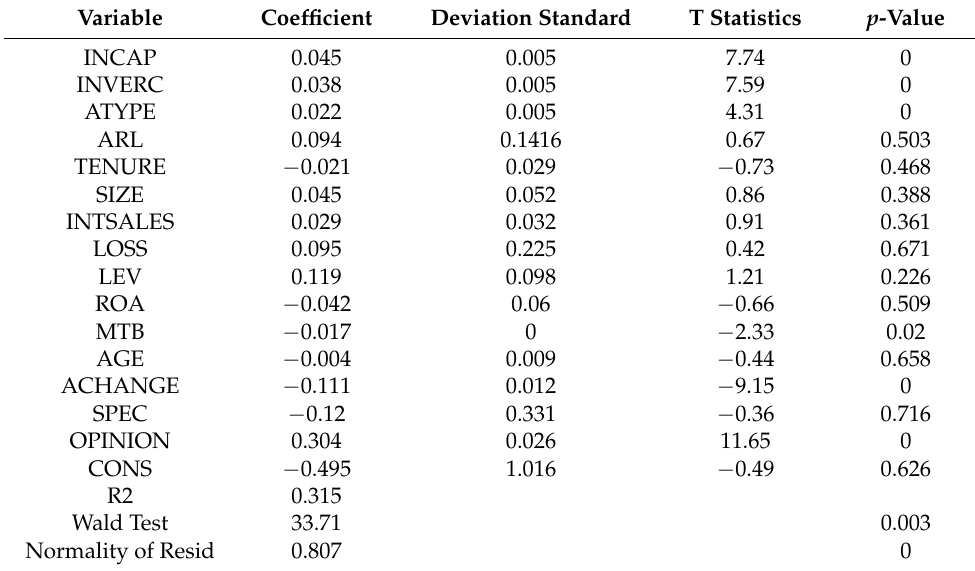
Table 7. The results of estimating the second model by the stochastic effects